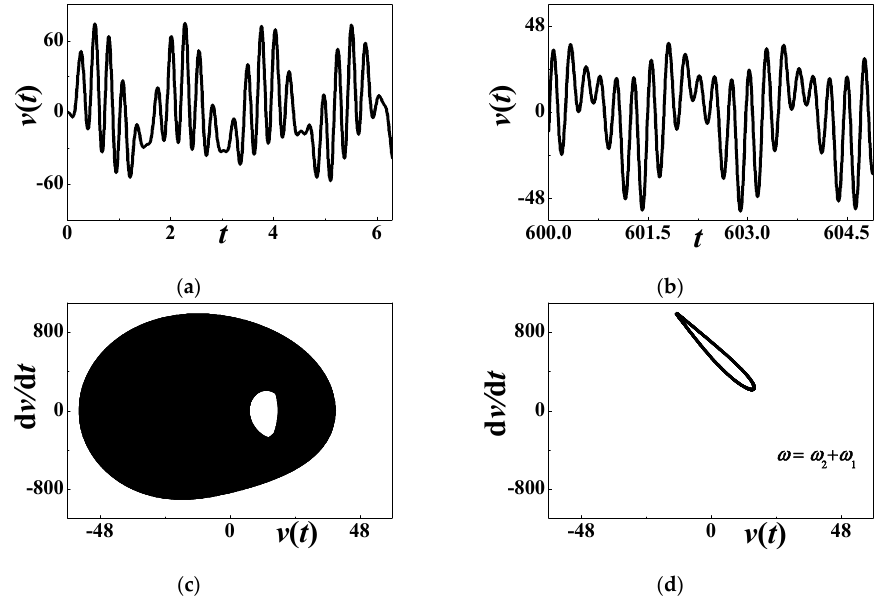
Figure 3. The periodic response when ω = 25: ( a ) initial history; ( b ) steady-state response; ( c ) phase diagram; ( d ) Poincare map. The solid blue dots stand for analytical prediction and others for numerical simulation.